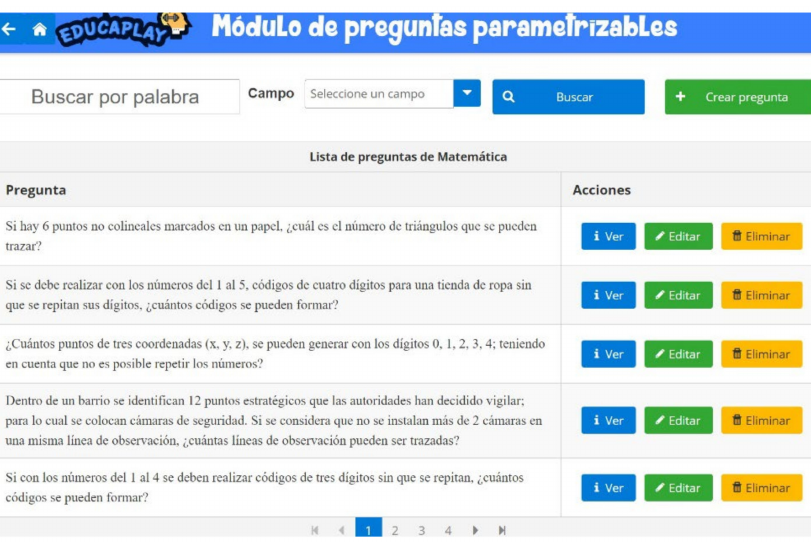
Figure 21. Administrator